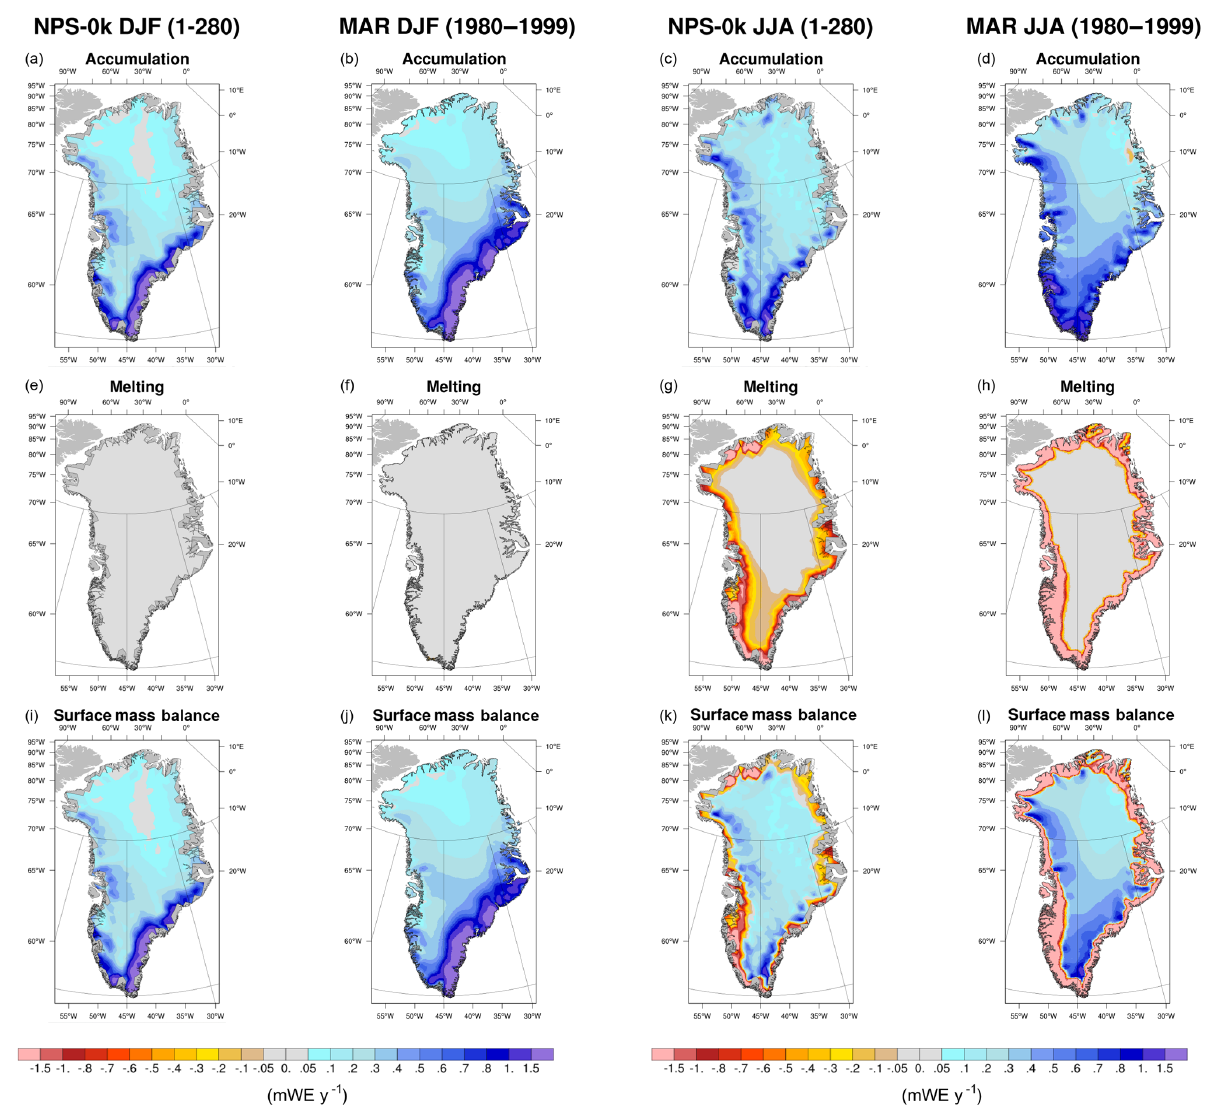
Figure 4. Seasonal (DJF, left two columns and JJA, right two columns) mean accumulation (top row), melting (middle row) and SMB (bottom row) over Greenland from NPS-0k (a, c, e, g, i, k) and MAR (b, d, f, h, j, l)